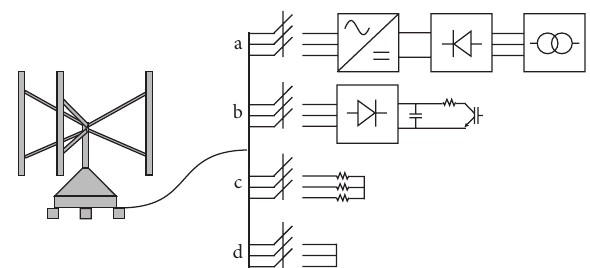
Figure 3: Schematic illustration of the control system. The turbine and generator have a common shaft. The three phases of the generator can be connected to different parts of the control system. (a) shows startup (right to left) where a DC source feeds an inverter which is controlled to start the machine, (b) is the regular controlled load, (c) is an emergency brake, and (d) is the parking brake.